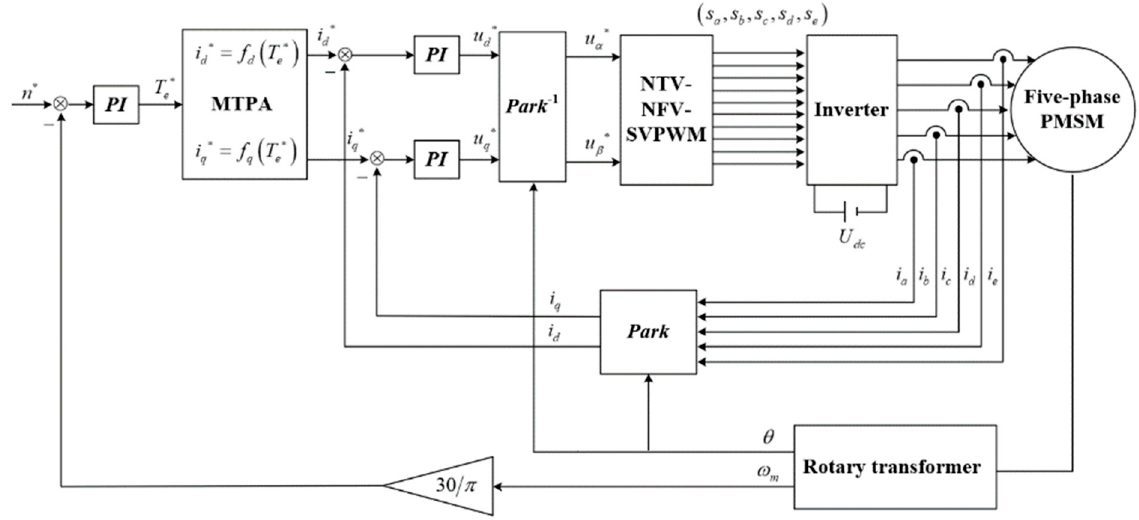
Figure 19. MPTA control of the five-phase PMSM block diagram.